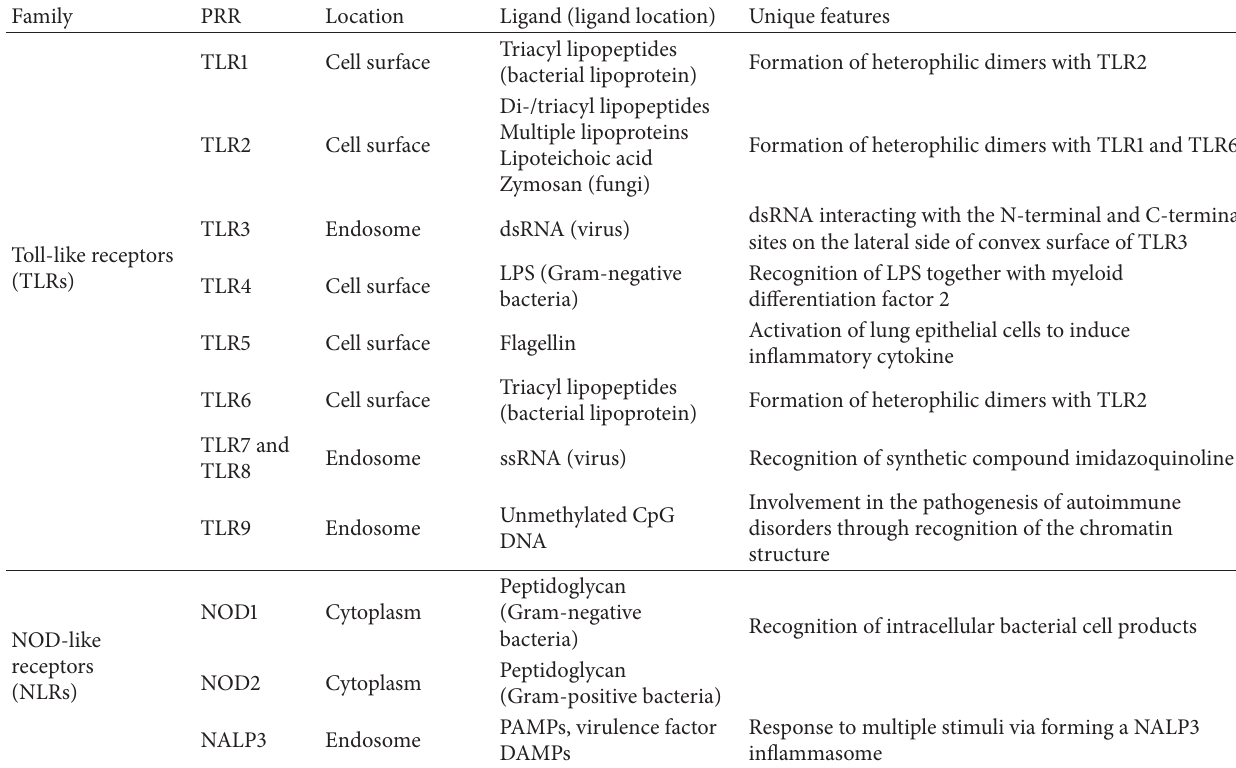
Table 1: Summary of TLRs and NLRs in human innate